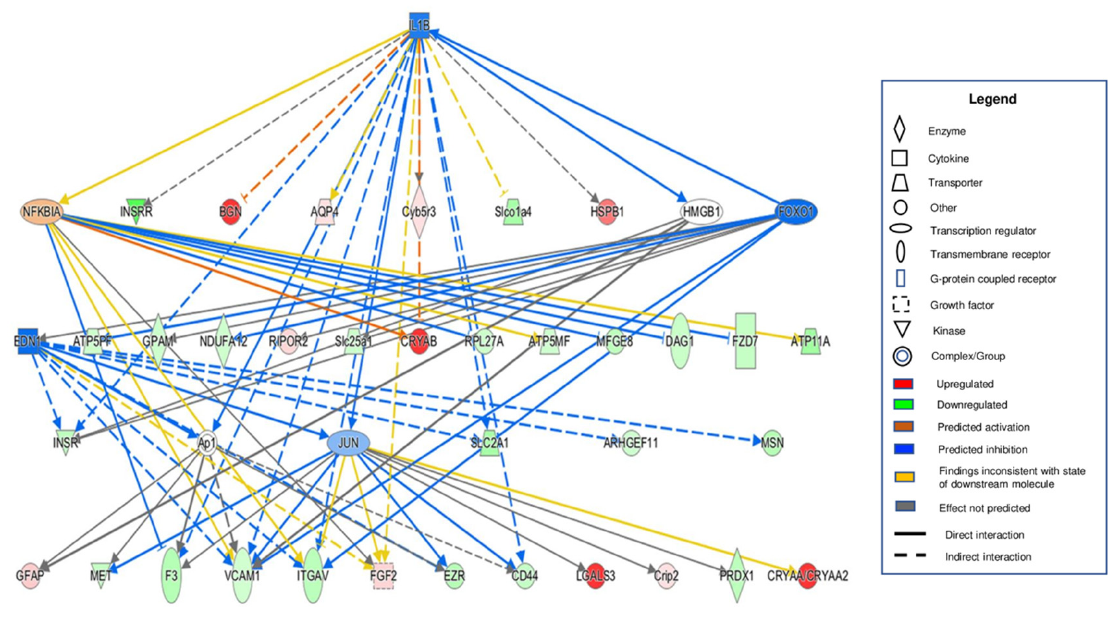
Figure 6. Interaction map depicting MAM proteins and their involvement with major inflammatory mediators. MAM proteins identified to have interactions with inflammatory mediators were selected from the 179 altered MAM proteins in the Type 1 diabetic condition. Numerous interactions were specifically identified with Interleukin-1 β (IL-1 β ), NF-kappa-B inhibitor alpha (NF- κ BIA), Forkhead box protein O1 (FOXO1), endothelin-1 (EDN1), and c-Jun (JUN). The functional networks were generated through IPA. Legend in the box displays molecules and function symbol, types, and colors. Lighter shades of red, green, and blue represent decreased intensities of up-regulation, down-regulation, and inhibition, respectively. MAM: Mitochondria-associated ER membrane, IPA: Ingenuity pathway analysis.